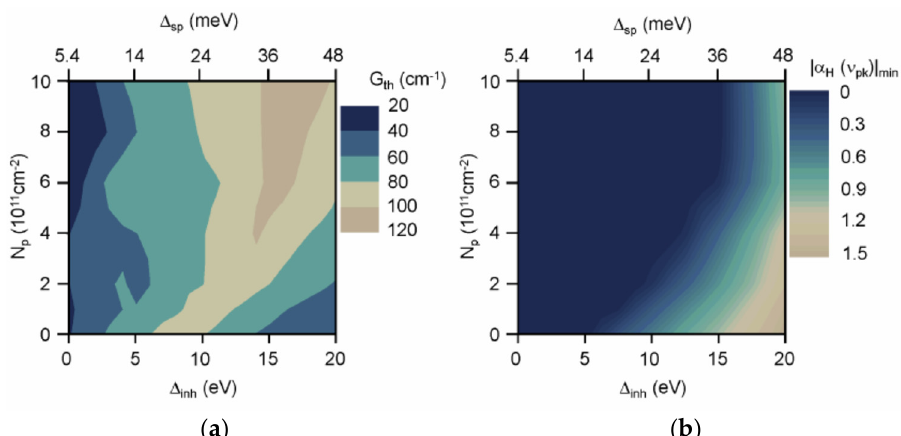
Figure 11. ( a ) Combinations of inhomogeneous width, p-dope density and threshold gain for lasing at gain peak with minimum absolute value of α H . ( b ) Minimum absolute value of α H at gain peak resulting from operating with combinations in Figure 7a. Reprinted with permission from Ref. [37].